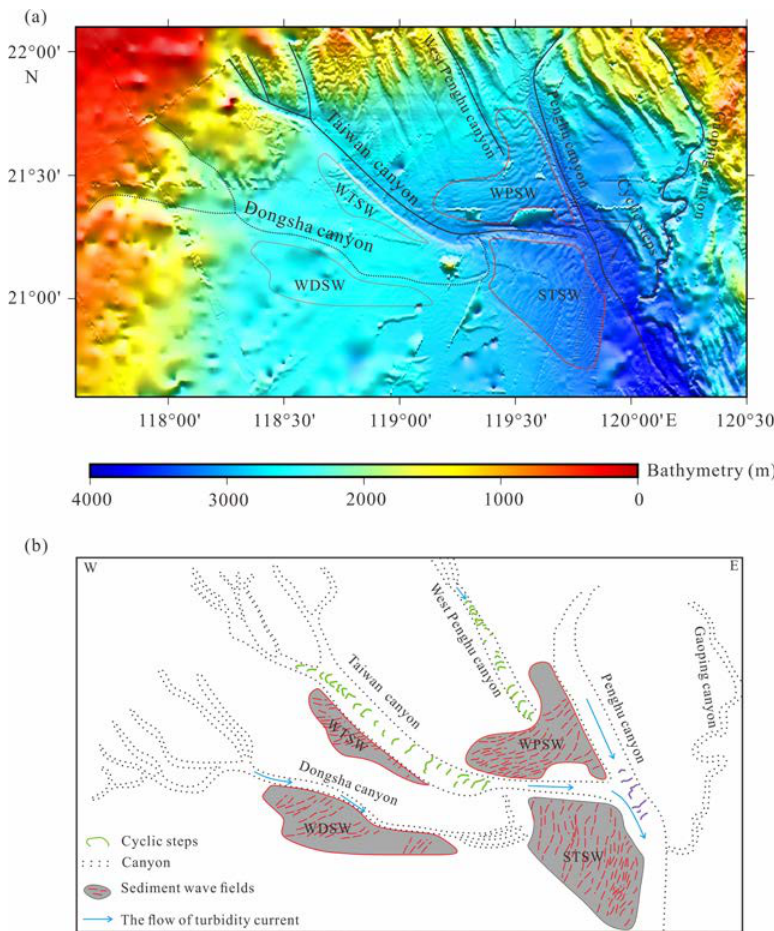
Figure 8. Distribution and explained patterns of cyclic steps and sediment wave in the Taixinan canyon group. ( a ) Cyclic steps and sediment wave distributed in the northern South China Sea. ( b ) Schematic formation pattern of cyclic steps in the Penghu canyon. The cyclic steps developed at the lower section of the Penghu canyon are formed by the combined effect of turbidity current between the Taiwan canyon and Penghu canyon. The green line represents the cyclic steps previously found in the northern part of the South China Sea [9,15]. The purple line represents the cyclic steps newly found in this study. Sediment waves: WDSW = West Dongsha canyon sediment wave field; WTSW = West Taiwan canyon sediment wave field; STSW = South Taiwan Canyon sediment wave field; WPSW = West Penghu canyon sediment wave field [16,31]. Blue arrows: turbidity current flow direction [9,15].